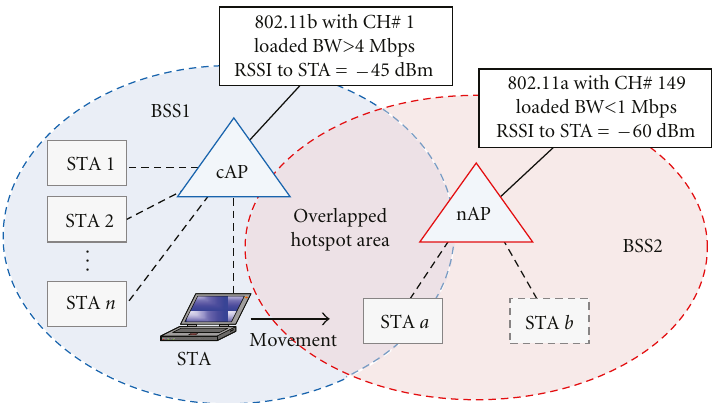
Figure 1: A scenario for MAC layer hando ff within overlapped hotspot area.